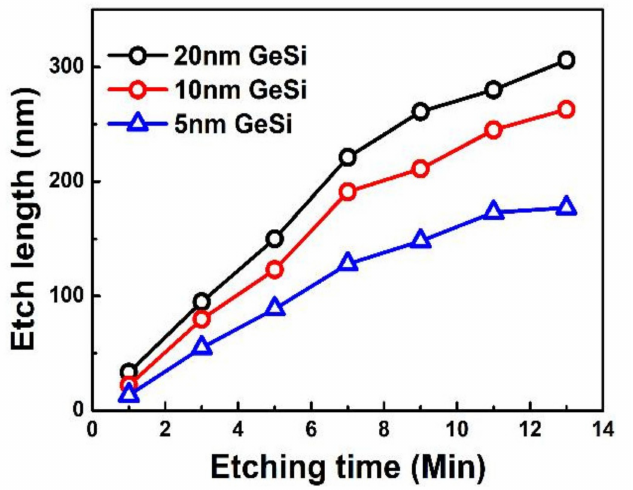
Figure 3. Etch lengths of GeSi layer as a function of etching times for GeSi/Si samples with different GeSi